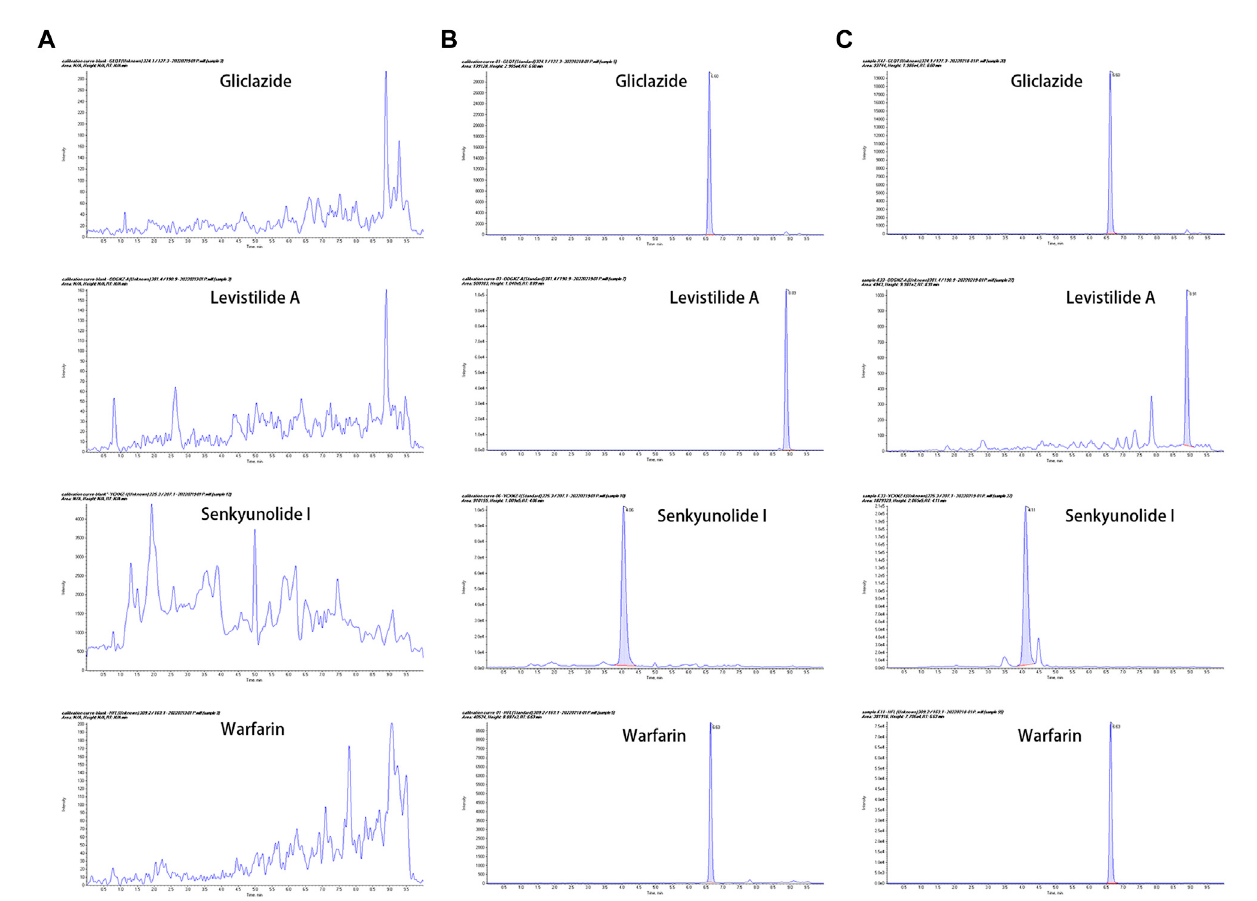
FIGURE 1 The representative MRM chromatograms (A) Blank plasma samples from MCAO rats; (B) Blank plasma samples spiked with gliclazide (IS), levistilide A, senkyunolide I, and warfarin; (C) Plasma from MCAO rats after co-administration of warfarin and Chuanxiong Rhizoma. (From the top to the bottom: gliclazide, levistilide A, senkyunolide I, and